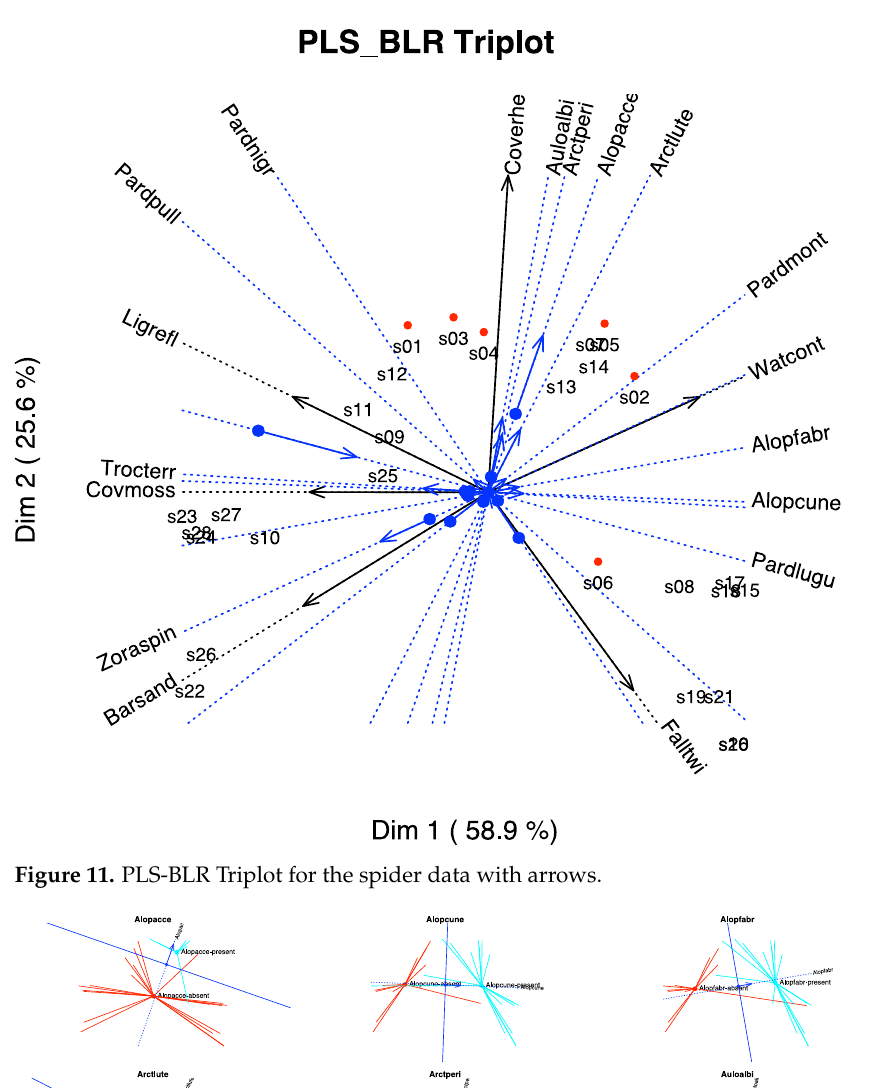
Figure 11. PLS-BLR Triplot for the spider data with arrows.